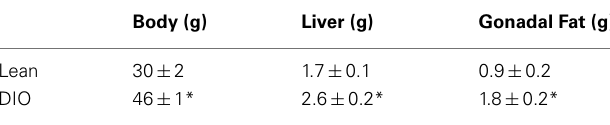
Table 2 | Body, liver, and gonadal fat pad weights of lean and DIO mice. Body (g) Liver